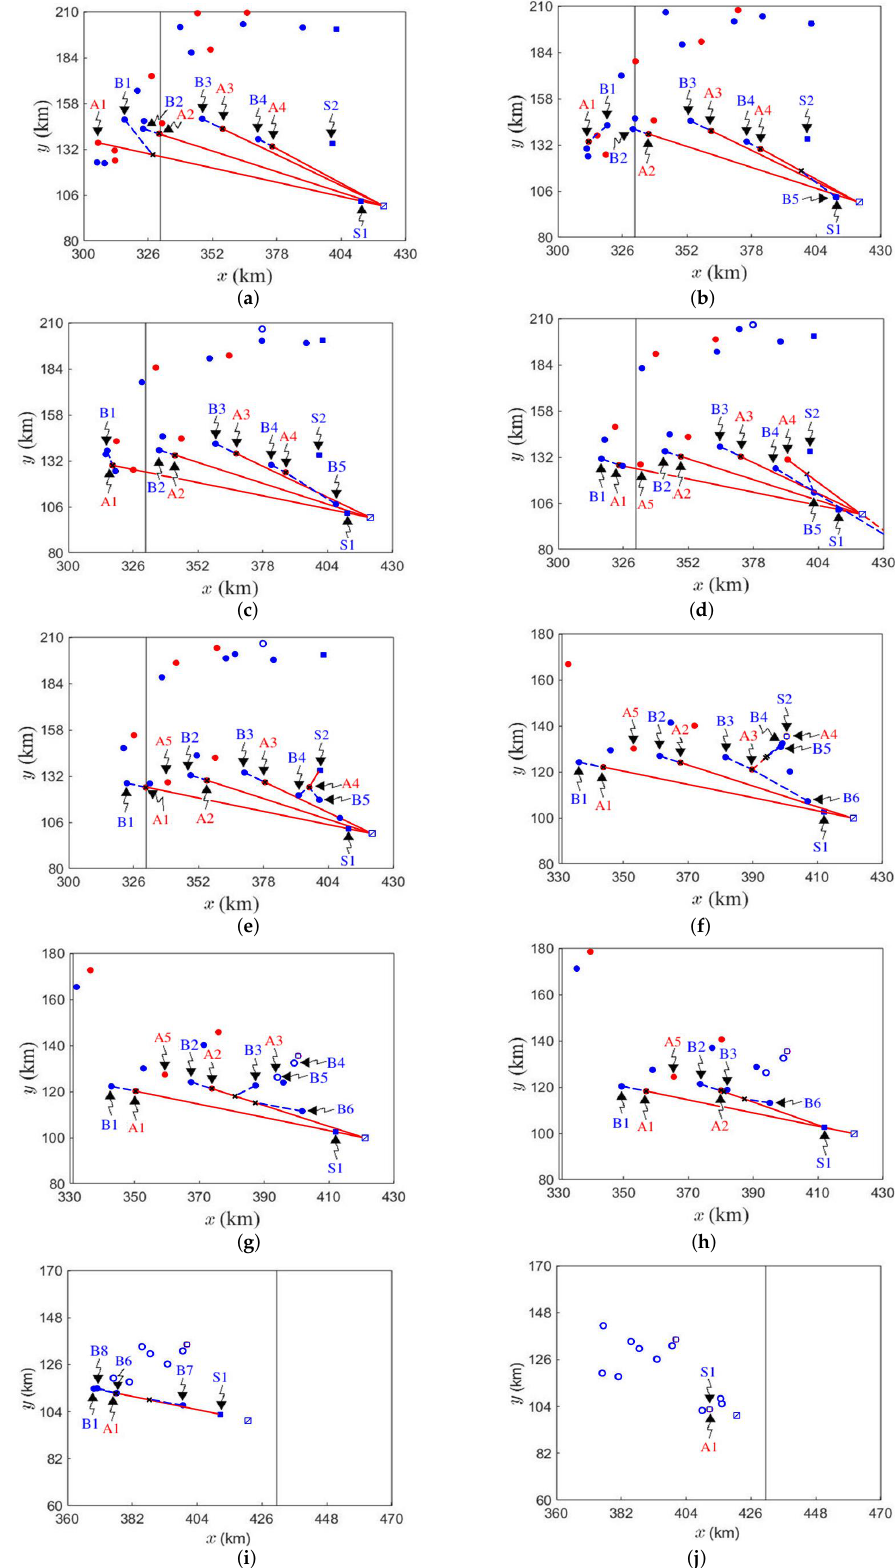
Figure 12. Scenario in case 1 on ζ 4 , against slant formation, ( a ) t = 860 s; ( b ) t = 880 s; ( c ) t = 900 s; ( d ) t = 920 s; ( e ) t = 940 s; ( f ) t = 980 s; ( g ) t = 1000 s; ( h ) t = 1020 s; ( i ) t = 1080 s; ( j ) t = 1240 s, • :